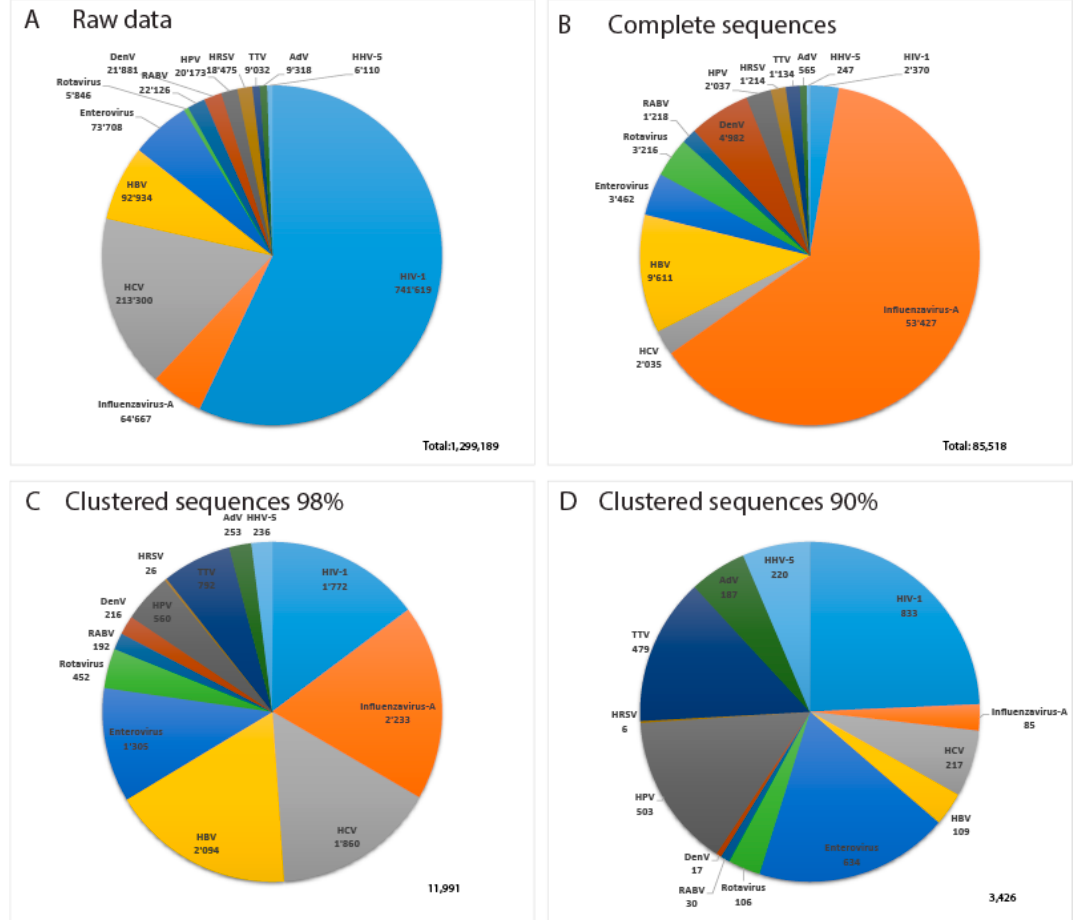
Figure 4. Relative number of sequences for the 13 most sequenced human viruses: ( A ) total sequences from GenBank, ( B ) complete virus sequences, ( C ) Virosaurus 98 and ( D ) Virosaurus 90. (Data from release 2019_10).